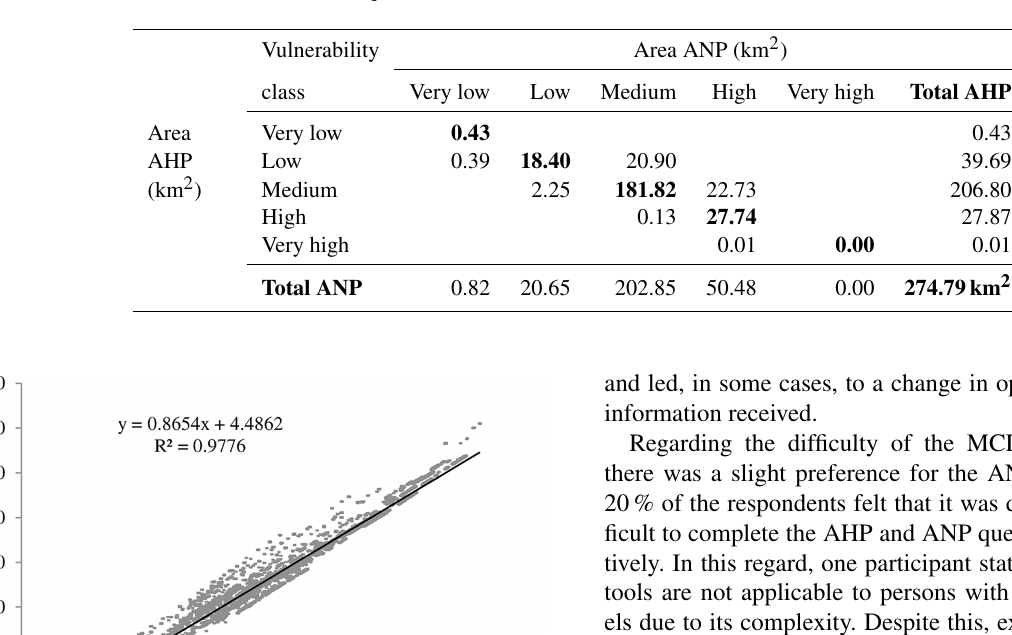
Table 4. Comparison of vulnerability classes according to the AHP and ANP models. Diagonal values correspond to areas that were classified equally by both models. The column sum shows the area that is occupied by the respective class of vulnerability in the ANP technique while the line sum shows the area in the AHP technique.